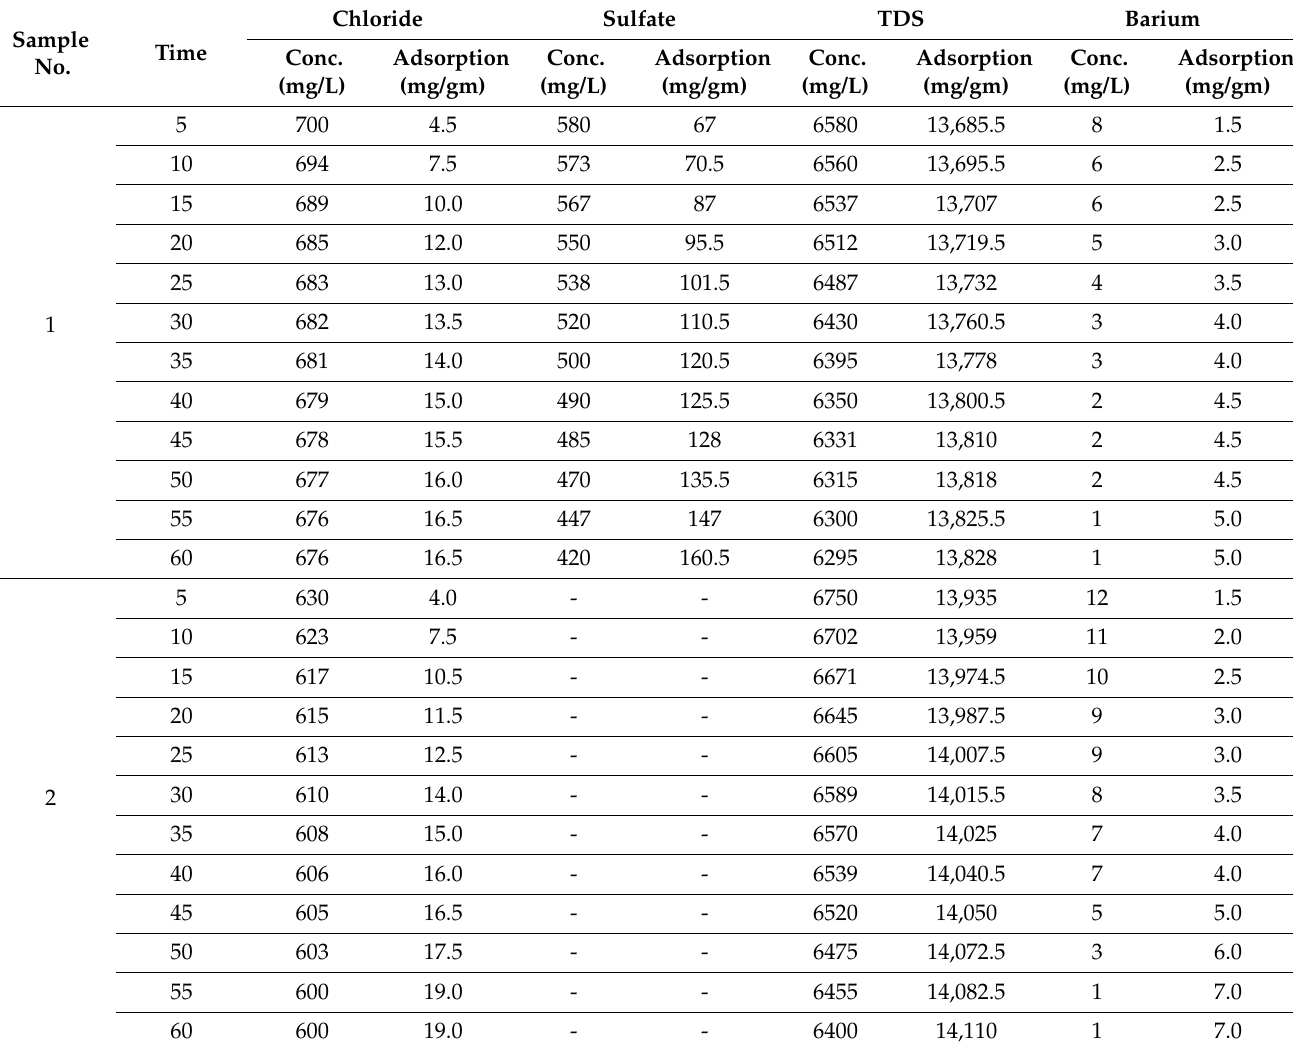
Table 7. Adsorption concentrations (mg/gm) of chloride, sulfate, TDS and barium from industrial wastewater at different time